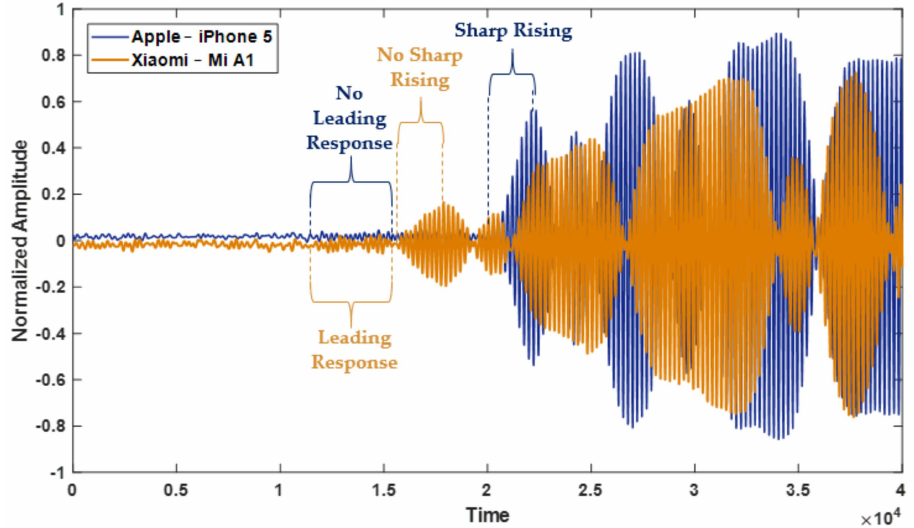
Figure 4. Comparison of Wi-Fi signals in terms of leading response and sharpness of